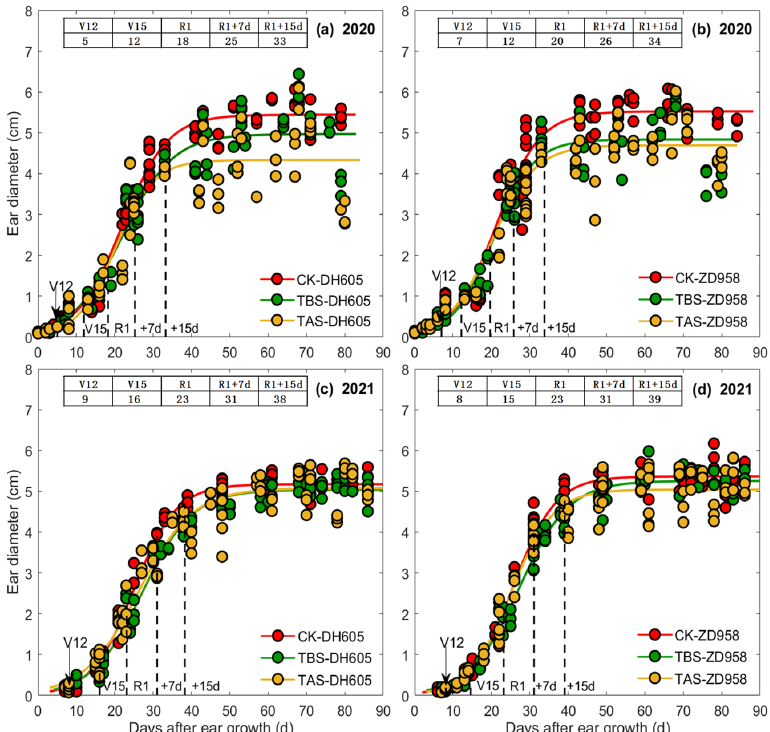
Figure 3. Ear diameters of DH605 ( a,c ) and ZD958 ( b,d ) at different development stages under different heat stress treatments in 2020 ( a,c ) and 2021 ( b,d ).